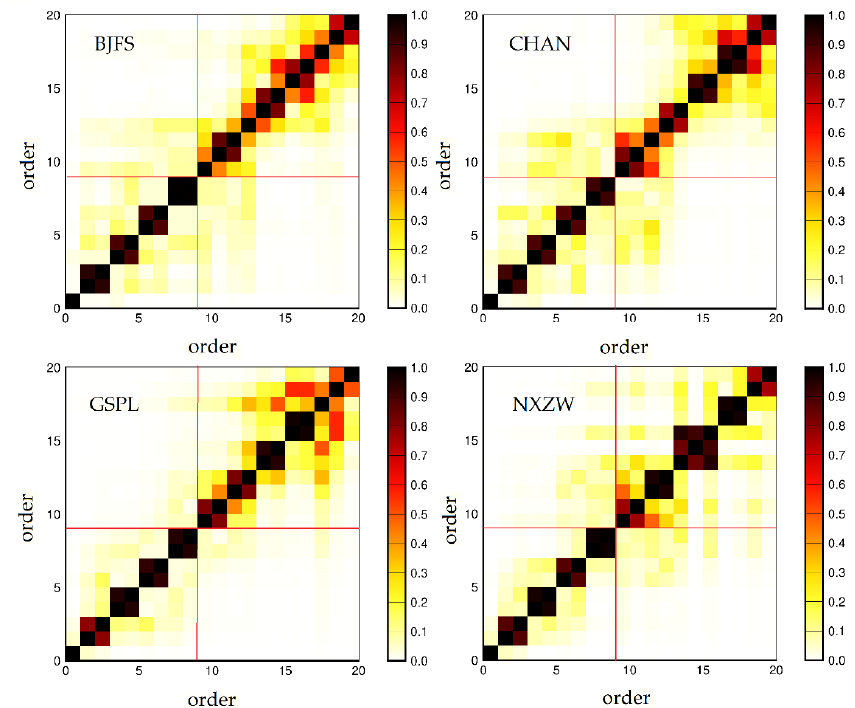
Figure 7. Results of W-correlation analysis.